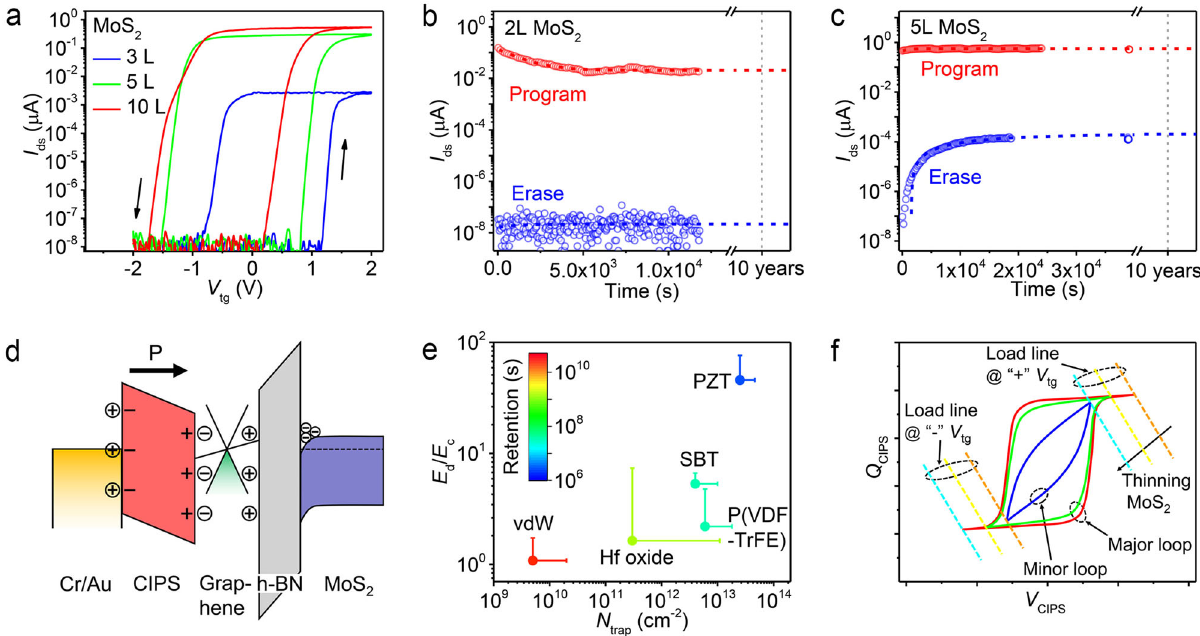
Fig. 5 Analysis of memory retention performance of vdW FeFET. a Top-gate transfer characteristics of vdW FeFETs with different thickness of MoS 2 . b , c Program and erase state retention properties of the vdW FeFET with bilayer b and fi ve-layer c MoS 2 after voltage pulses of ± 3 V/1 s. I ds was monitored at V ds = 0.5 V and V tg = 0 V. Dashed red and blue lines are the fi tting using the exponential decay function. The thickness of CIPS fl ake is 39 nm ( b ) and 66 nm ( c ). d Schematic band diagram and charge distribution of a vdW FeFET during retention time of the program state. e Calculated retention time vs. E E N d / c ratio and trap for vdW FeFET, P(VDF-TrFE), PZT, SBT, and hafnium oxide based FeFETs. Error bars indicate the range of variation for f Load-line analysis of layer-dependent retention performance of vdW FeFET. The solid lines are hysteresis loops of MFM capacitor at different statuses. The dashed color lines are load line curves of underlying 2D FET with different thickness of MoS 2 under the same magnitude of V tg